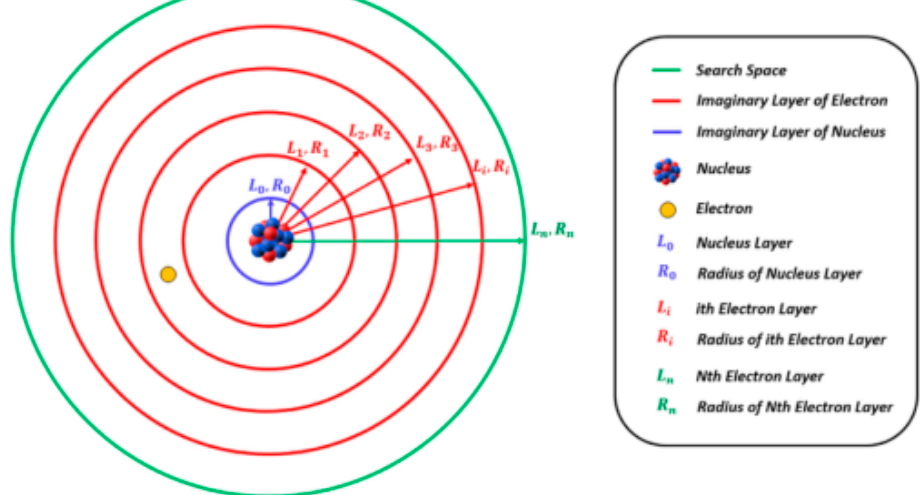
Figure 1. Schematic presentation of imaginary layers around nucleus.